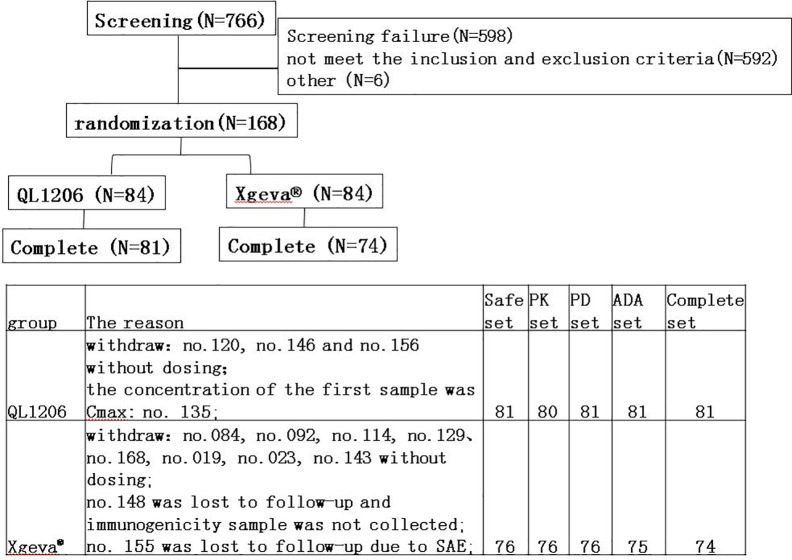
Flow chart of the study.